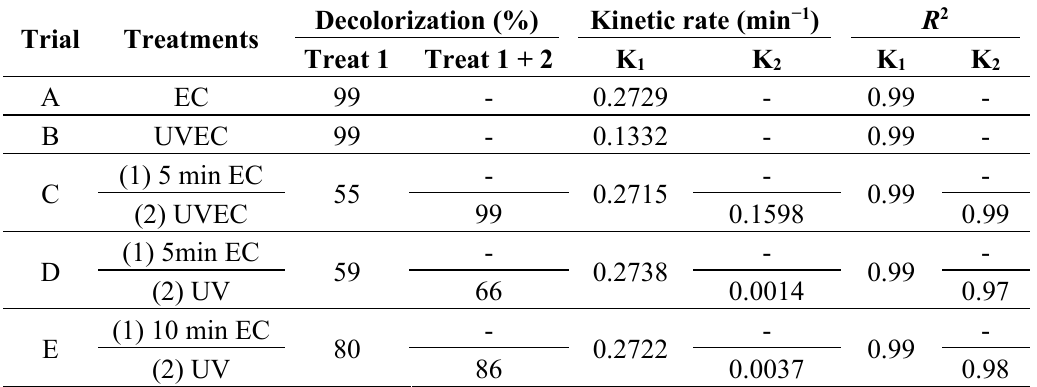
Where: EC = electrochemical treatment. UVEC = electrochemical treatment with simultaneous UV radiation. EC + UV = electrochemical treatment with posterior UV radiation. K 1 : kinetic rate corresponding to treatment 1. K 2 : kinetic rate corresponding to treatment